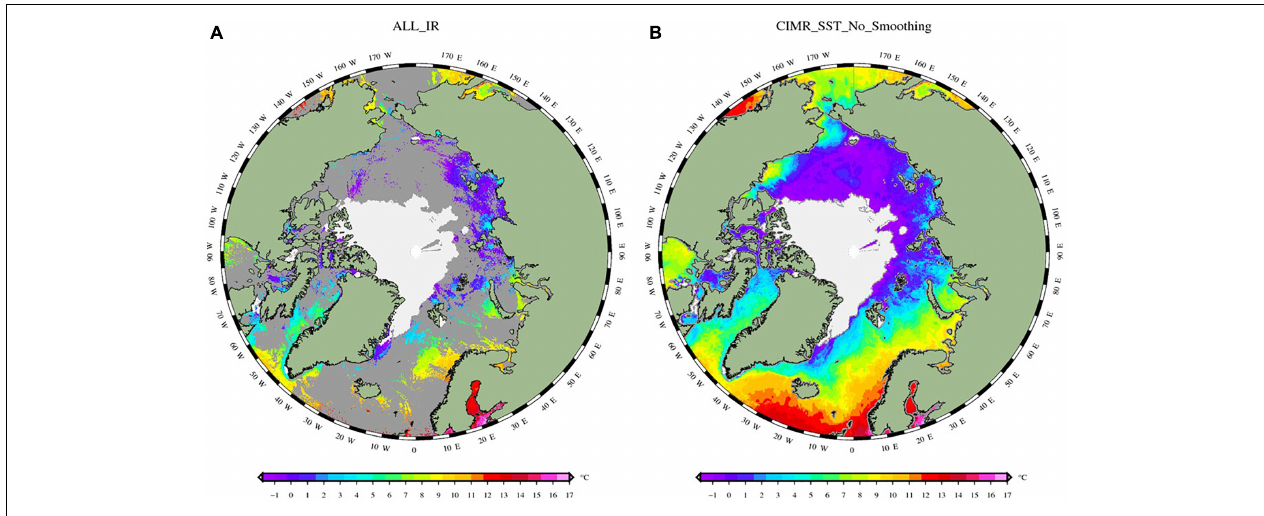
FIGURE 11 | Data coverage of (A) all available Infrared satellites during the sea ice minimum in September 2012 (taken from Copernicus Marine Environmental Services (CMEMS) data production). (B) Simulated CIMR coverage for the same period. (Reproduced by permission under CC-BY 4.0 from https://doi.org/10.6084/